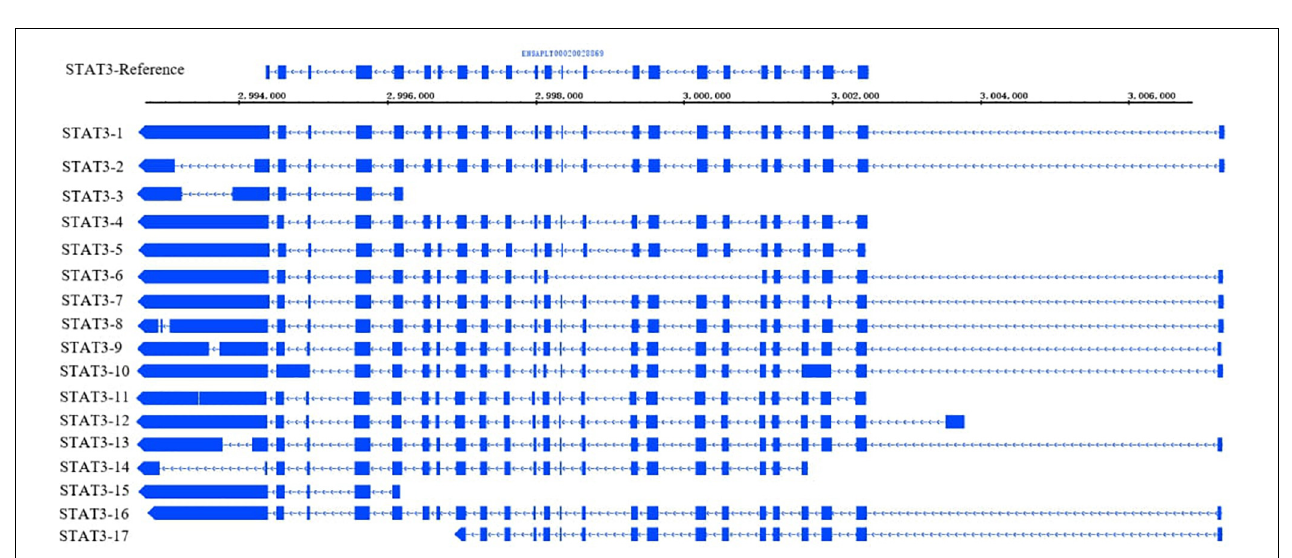
FIGURE 8 | STAT gene transcripts structure